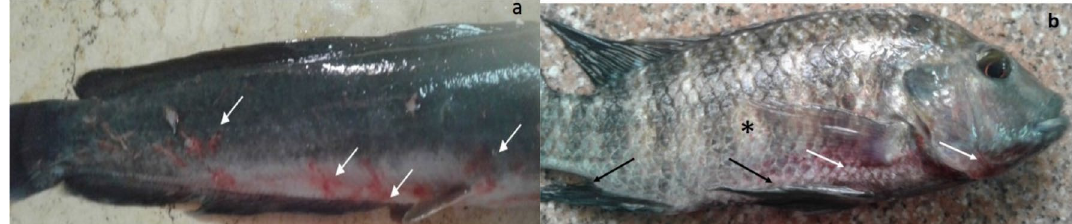
Figure 1. Clinical examination of naturally infected fish ( a ) catfish ( Clarias gariepinus ) showing irregular hemorrhages on external body surfaces, especially at the ventral part of the abdomen and around the vent (white arrows), ( b ) Nile tilapia ( Oreochromis niloticus ) showing scattered hemorrhagic spots (white arrows), detached scales (*), and fins erosion (black